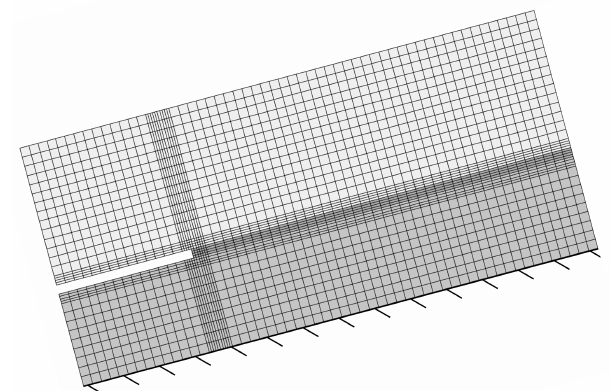
Table 1. Material properties used throughout the present work.